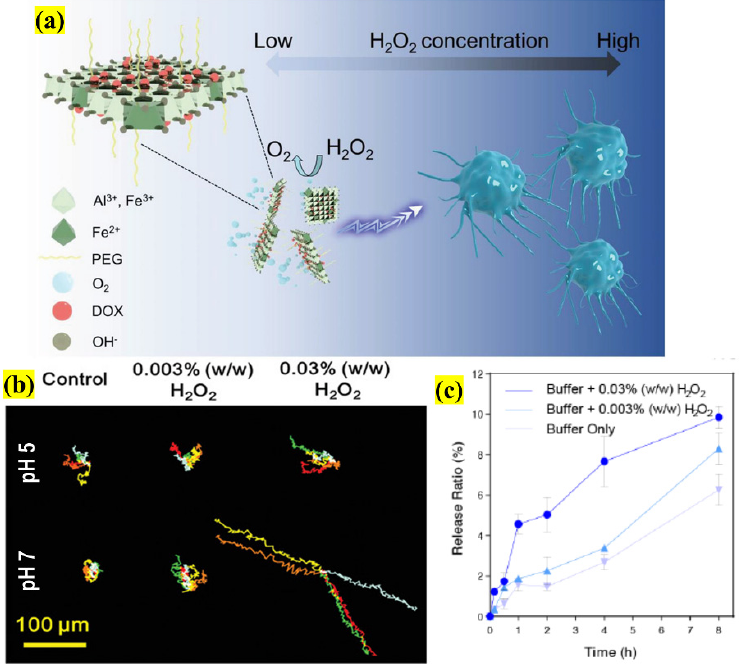
Figure 14. Schematic illustration of ( a ) the design of an LDHs 2D NSs stimuli-responsive nanomo- tor and its application in smart therapeutics using directional movement; ( b ) the trajectory move- ment of the nanomotor at different pHs and H 2 O 2 concentrations; ( c ) DOX release profile from the nanomotor at pH 7 based on H 2 O 2 fuel concentration for a period of 8 h (adapted with permission from Reference [14], Small, published by Wiley, 2020).